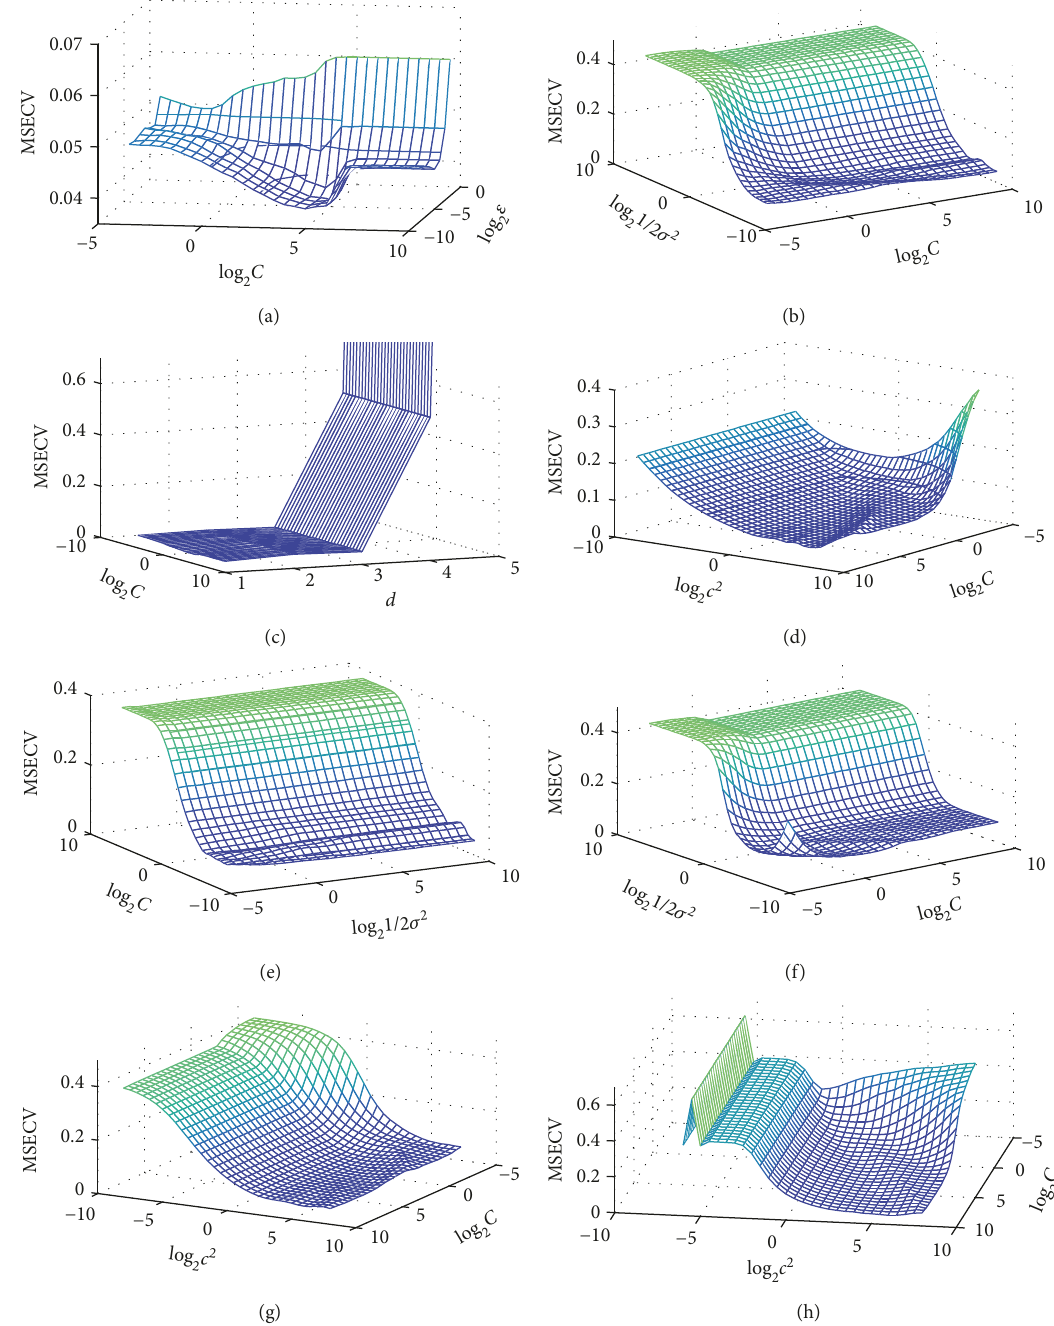
Figure 3: The in fl uence of penalty constant and kernel parameter on the MSECV of di ff erent kernels for SVR on UA dataset. (a) The in fl uence of penalty constant and nonsensitive loss on the MSECV of LinearSVR. (b – f) The penalty constant and kernel parameter curves of GSVR, PSVR, IMSVR, SLSVR, ESVR, RSVR, and